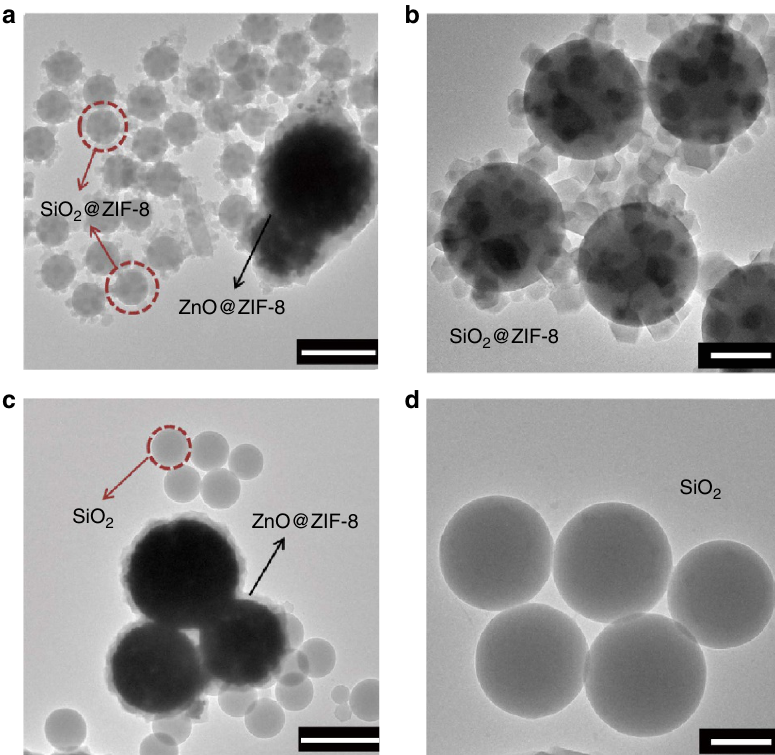
Figure 5 | Synthesis of ZnO@ZIF-8 with extra SiO 2 under different concentration of Hmim. TEM images of the products under ( a , b ) high concentration and ( c , d ) low concentration of Hmim. Micrographs b and d show the difference of the surface of SiO 2 in the two cases. ( b ) The conversion of ZnO into